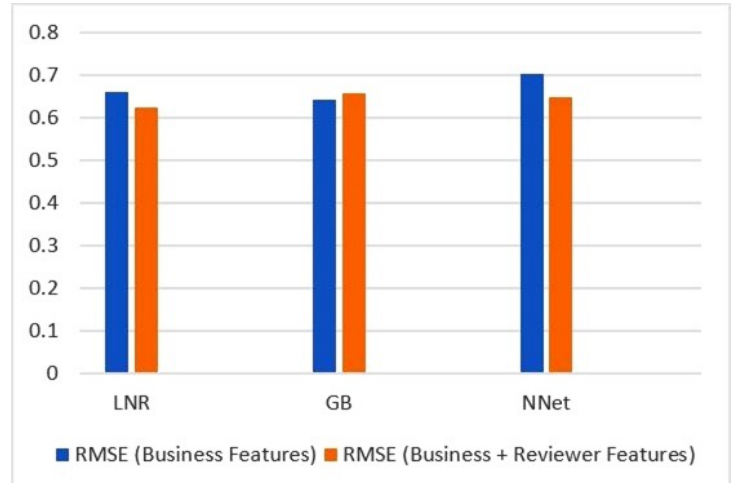
Figure 7. Comparison of RMSE for